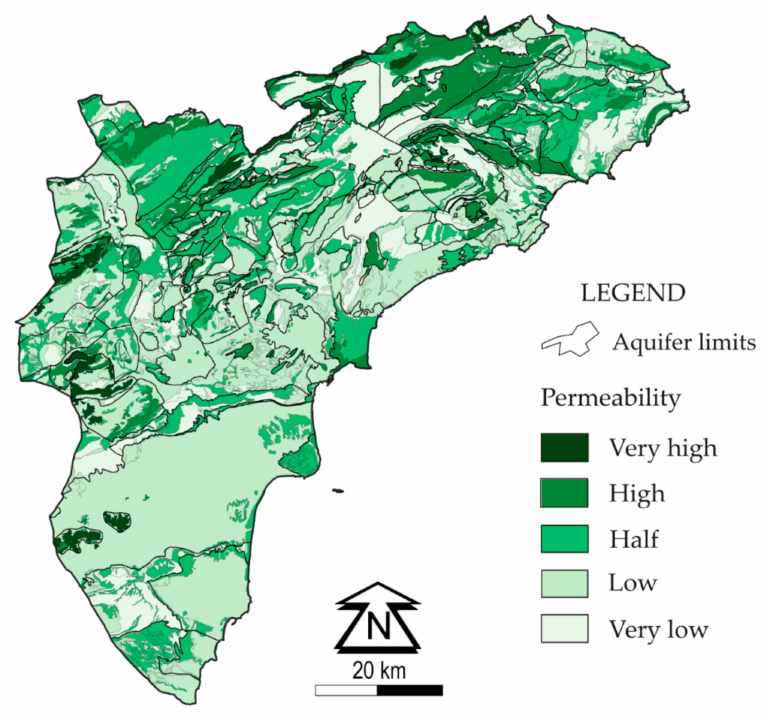
Figure 9. Permeability of the substrate in the Alicante province.